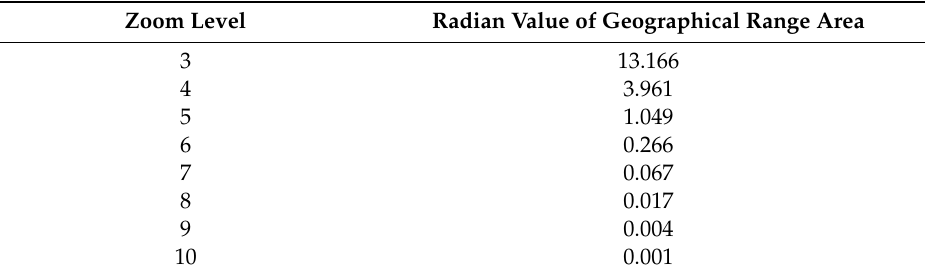
Table 1. Corresponding table of zoom level and the radian values of geographical range area.